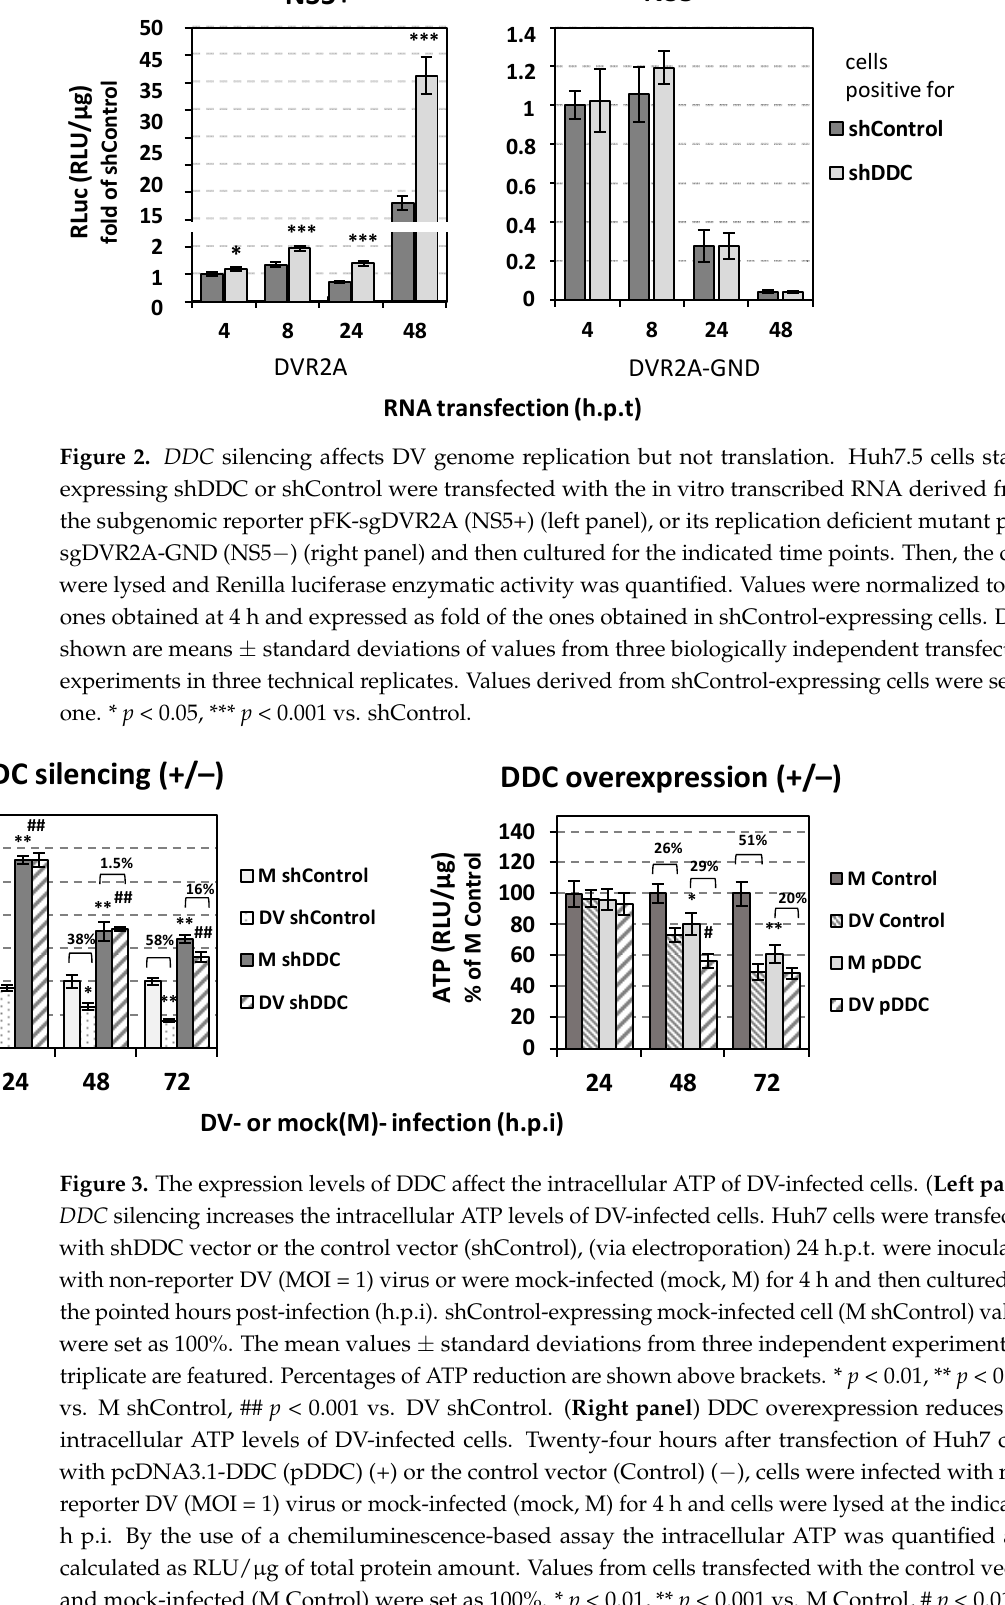
Figure 2. DDC silencing affects DV genome replication but not translation. Huh7.5 cells stably ex- pressing shDDC or shControl were transfected with the in vitro transcribed RNA derived from the subgenomic reporter pFK-sgDVR2A (NS5+) (left panel), or its replication deficient mutant pFK- sgDVR2A-GND (NS5 − ) (right panel) and then cultured for the indicated time points. Then, the cells were lysed and Renilla luciferase enzymatic activity was quantified. Values were normalized to the ones obtained at 4 h and expressed as fold of the ones obtained in shControl-expressing cells. Data shown are means ± standard deviations of values from three biologically independent transfection experiments in three technical replicates. Values derived from shControl-expressing cells were set as one. * p < 0.05, *** p < 0.001 vs. shControl.